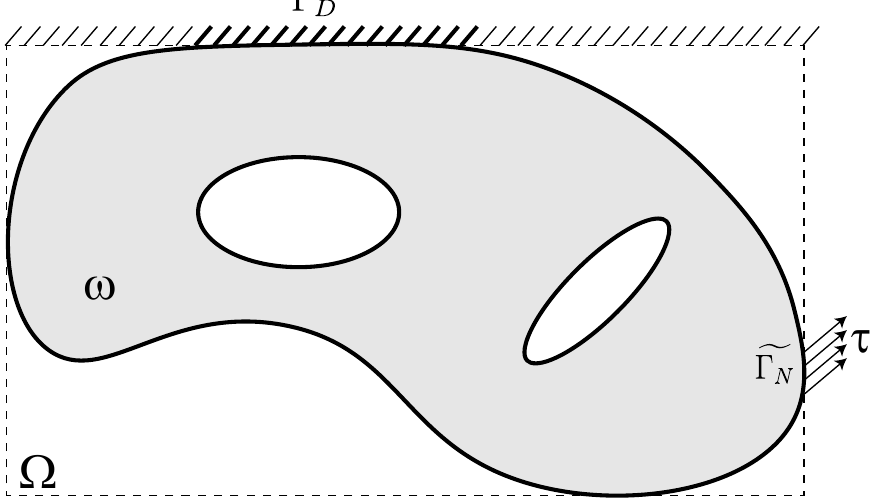
Figure 1. Extended design domain and boundary conditions for the state equation (adapted from